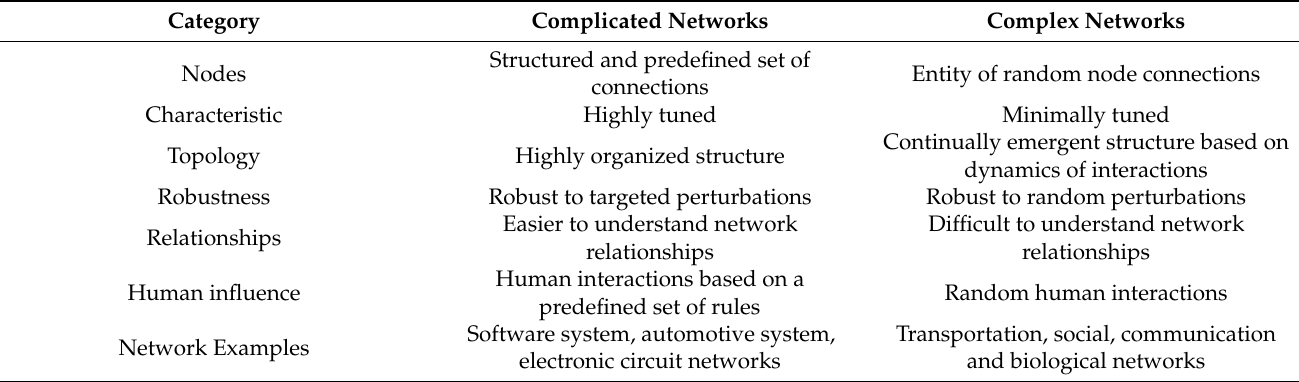
Table 1. Characteristics of complicated and complex